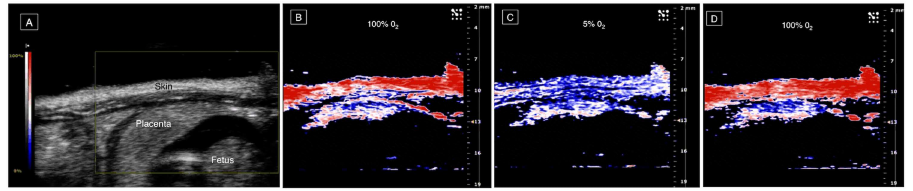
Fig 1. Photoacoustic (PA) imaging of placental oxygenation on day 14 of gestation. From left to right: (A) the placentain a sagittal plane (obtainedby a B-mode ultrasound scan) and parametric images created with the PA Oxyhemo mode making possiblethe evaluation of blood oxygen saturation duringvariations in the oxygen levels suppliedto the mother (5–100%).PA imagingsequencesduringhyperoxygenation (B), hypoxia (C) and hyperoxygenation (D).